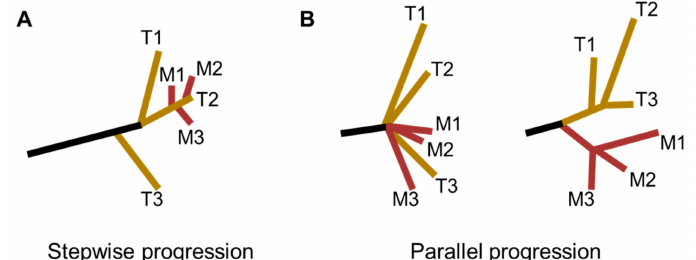
Figure 2. Phylogenic models for ESCC metastasis. ( A ) The stepwise progression model, in which metastases are seeded at the late stages of ESCC progression. This model was also described as the linear spread pattern by Yan et al. [44]. ( B ) The parallel progression model, in which tumor dissemination occurs at the early stages of ESCC progression. In this situation, dissemination of metastases could happen either ( Left ) explosively (explosive spread pattern) or via ( Right ) metastasis-to-metastasis pattern (T, Tumor; M,